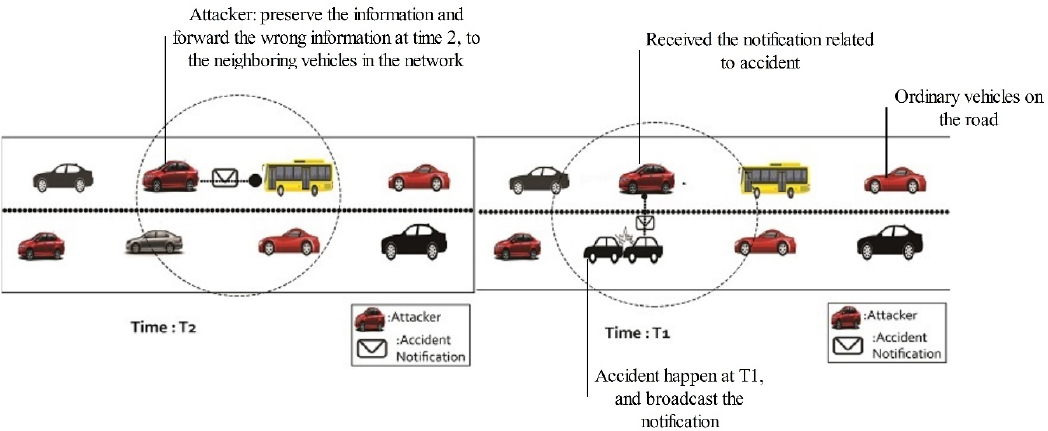
Figure 19. Replay attack in SDN-based VANETs.